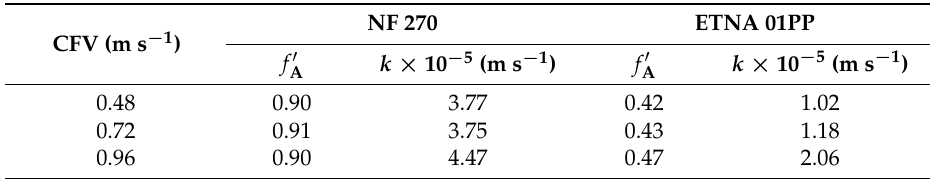
Table 2. Intrinsic rejection coefficient and experimental mass-transfer coefficient for NF 270 and ETNA 01PP membranes at different cross-flow feed velocities.